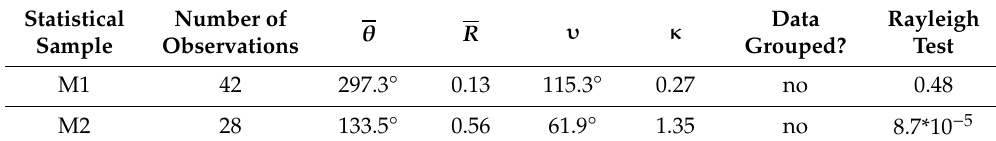
Table 6. Results of the basic statistics and the tests of fit to the uniform distribution (Rayleigh test) in samples M1 and M2.